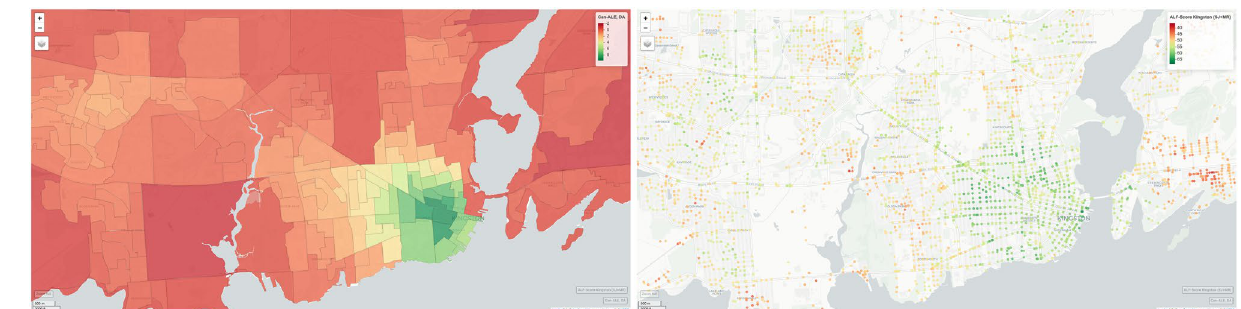
Figure 7. Left: Can-ALE for the city of Kingston, ON. Right: walkability results produced by ALF-Score++ for the city of Kingston, ON using the zero-user-input approach of a model trained through transfer learning based on user data from two cities of St. John’s and Montréal. The road network for Kingston maintains over 3400 nodes. ALF-Score’s walkability scores range between 0 and 100 units. This range can be adjusted if needed. (Maps generated through RStudio 44 Version 1.2 using mapview package from